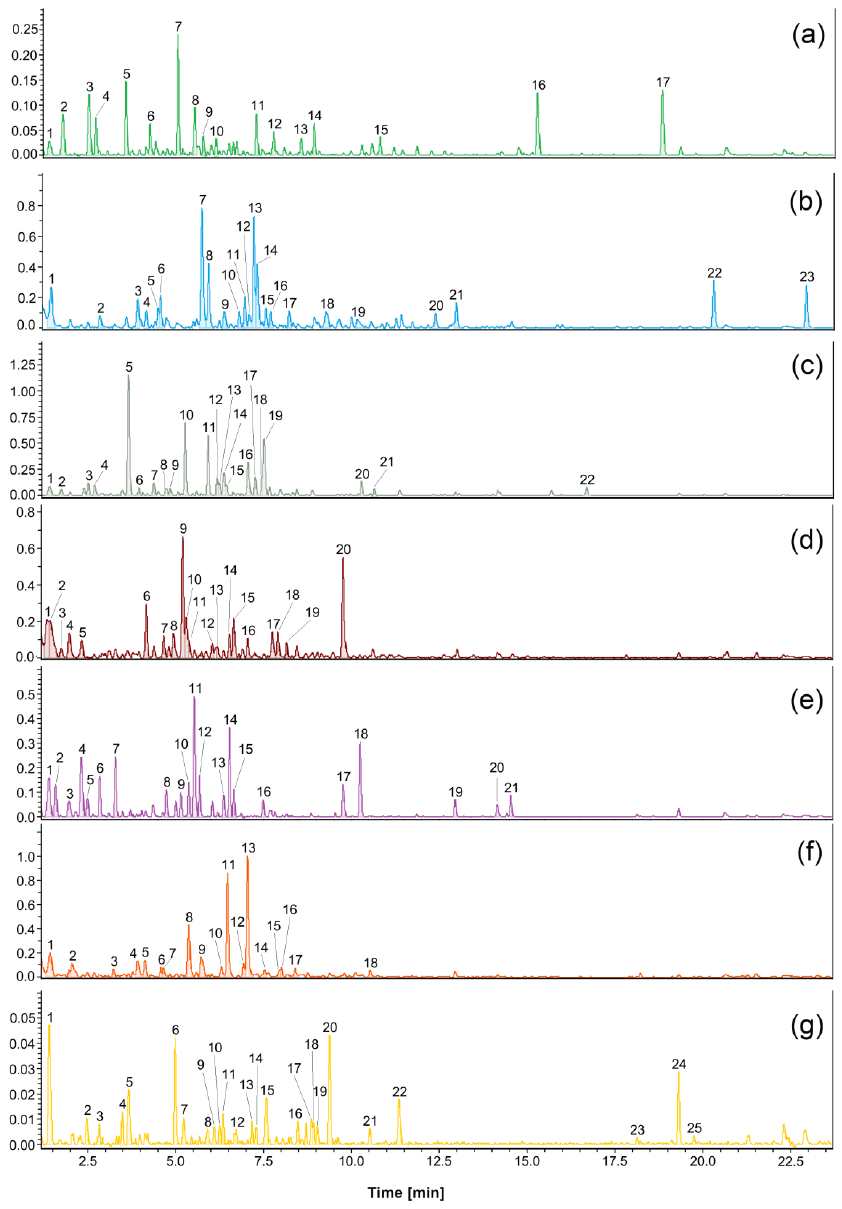
Figure 2. UHPLC-QTOF-CAD chromatograms of the studied plant extracts: ( a ) valerian ( Valeriana officinalis L.); ( b ) sage ( Salvia officinalis L.); ( c ) chamomile ( Matricaria chamomilla L.); ( d ) cistus ( Cistus L.); ( e ) linden blossom ( Tilia L.); ( f ) ribwort plantain ( Plantago lanceolata L.); and ( g ) marshmallow ( Althaea L.).